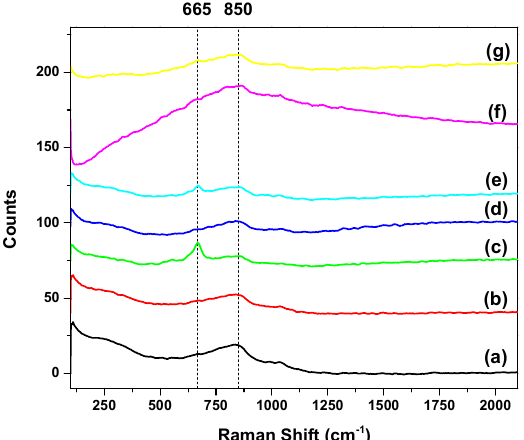
Figure 6. Raman spectra of the textured ASTM F-1537 cobalt alloy with six times process repetition at ( a ) non-textured, ( b ) 70%P-140 kHz, ( c ) 80%P-140 kHz, ( d ) 90%P-140 kHz, ( e ) 70%P-210 kHz, ( f ) 80%P-210 kHz, and ( g ) 90%P-210 kHz.